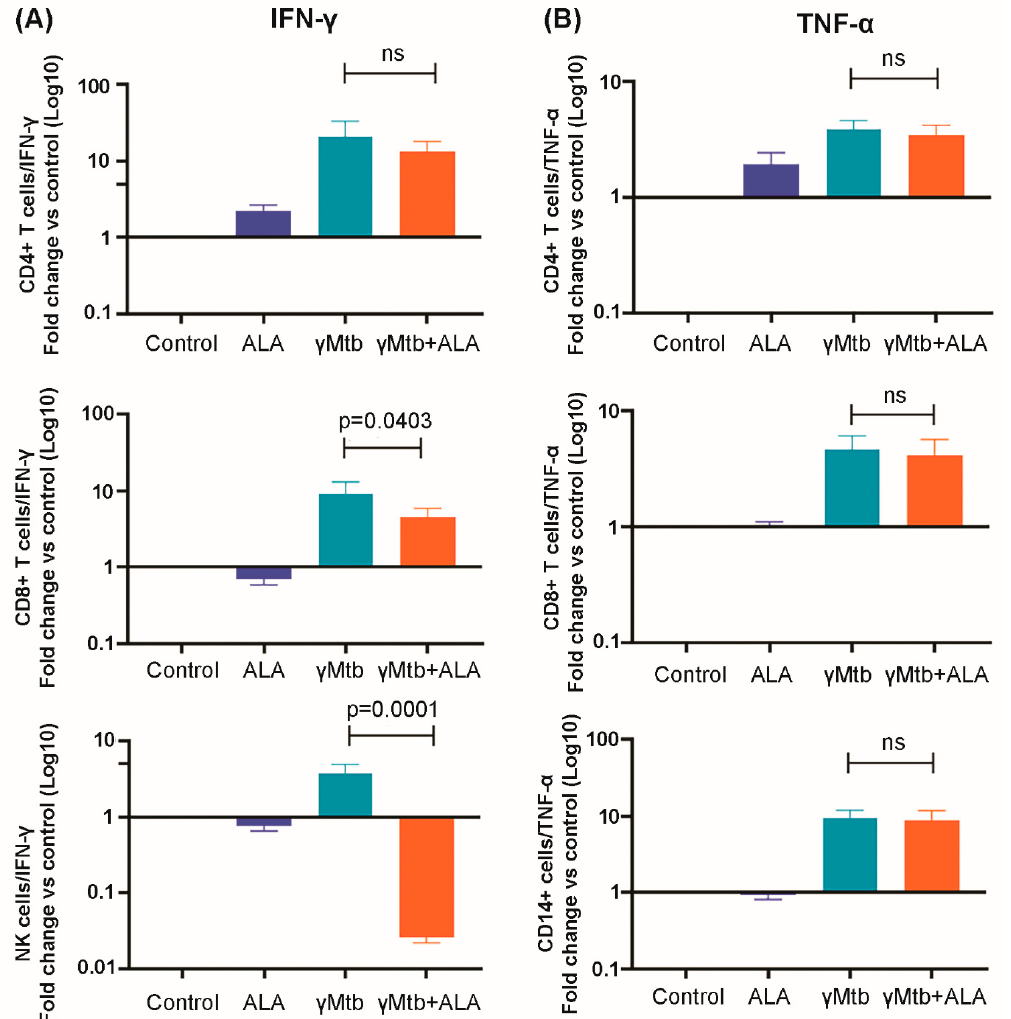
Figure 3. IFN- γ and TNF- α gene expression profile of various immune cells in γ Mtb -cultured PBMCs of LTBI+ donors. PBMCs of healthy LTBI+ donors were cultured with or without γ Mtb (10